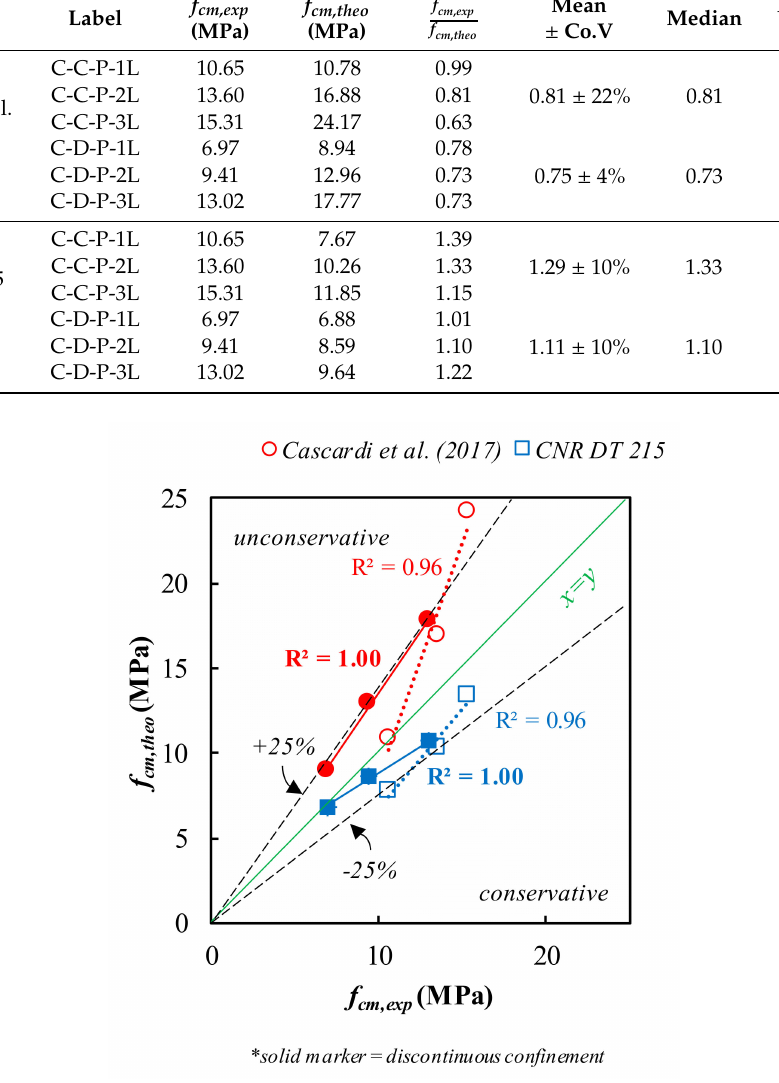
Figure 8. Experimental versus theoretical comparison of the axial